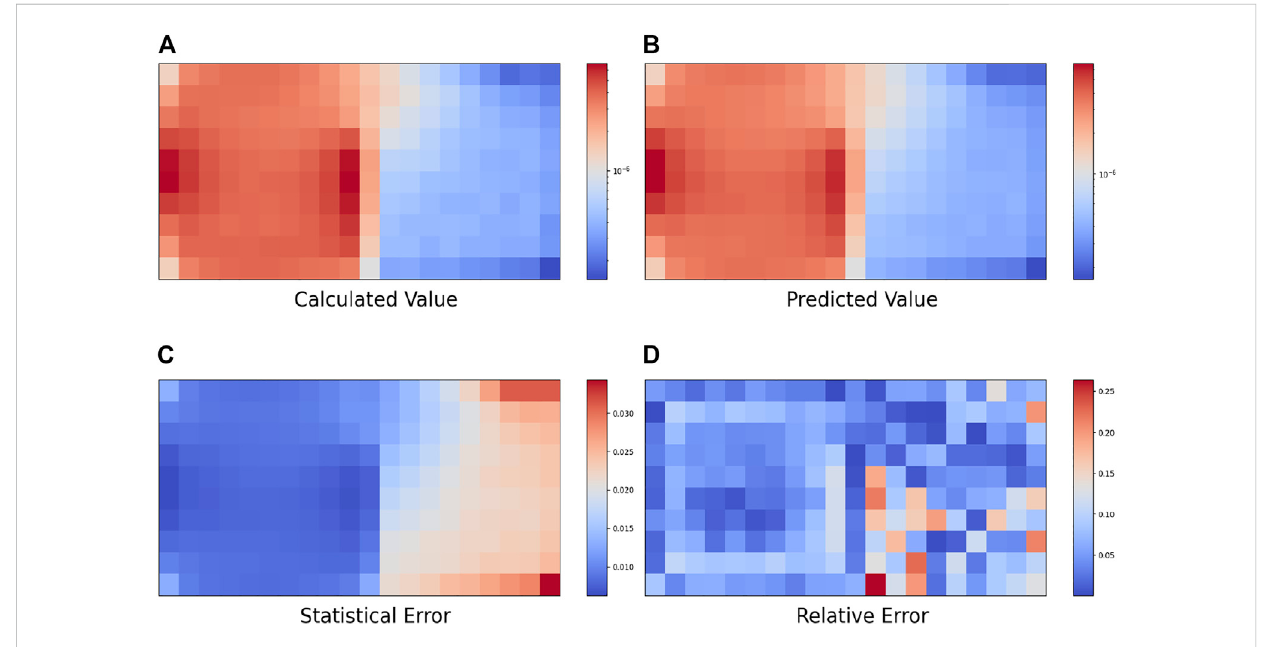
FIGURE 11 Reconstruction results of the 2D surface source term.